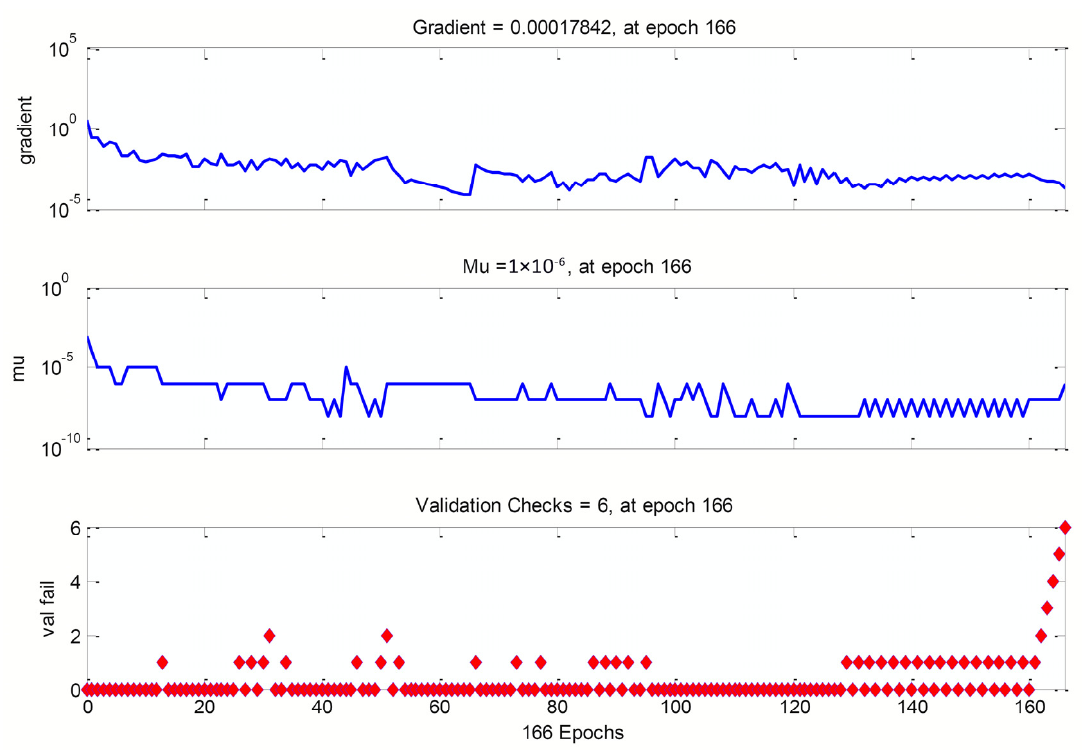
Figure 2. Validation Performance plot.